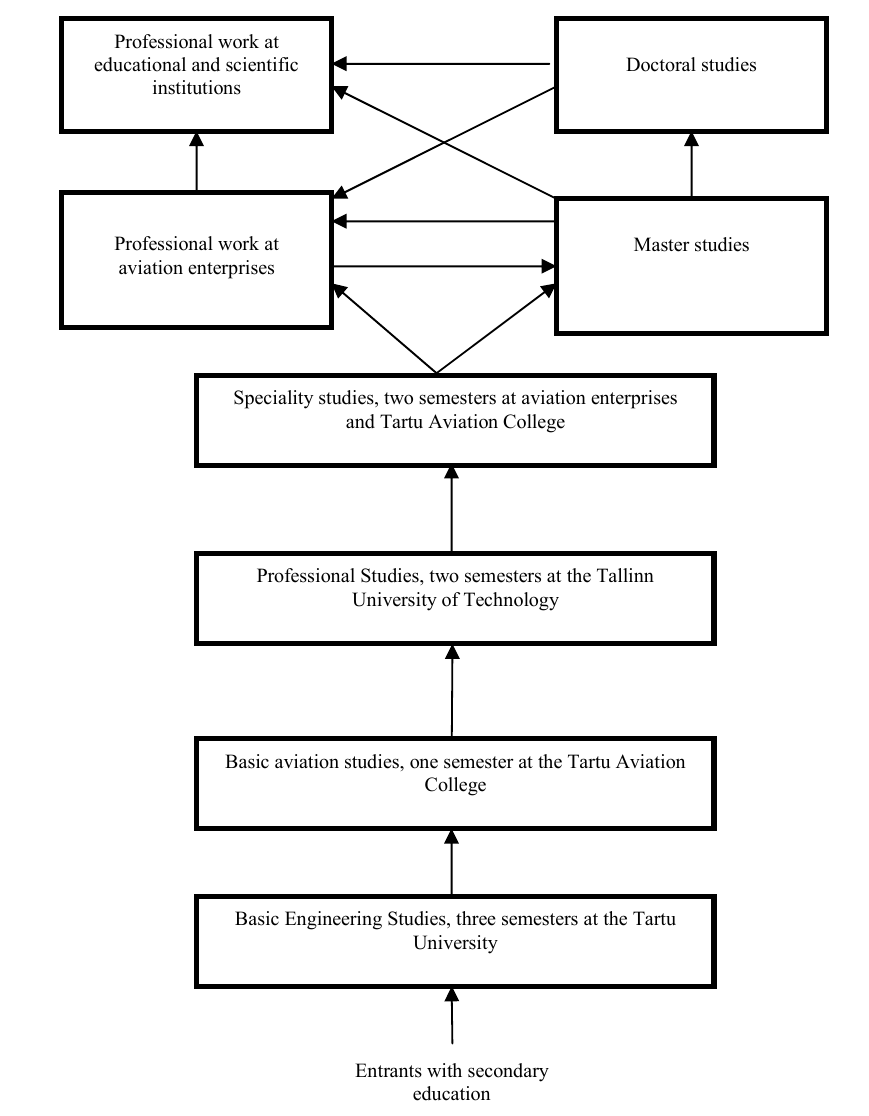
Fig. Scheme of training communication and navigation system